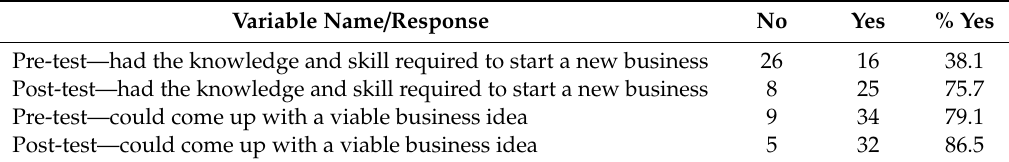
Table 5. Frequency Table of outcomes measures for entrepreneurial classes.